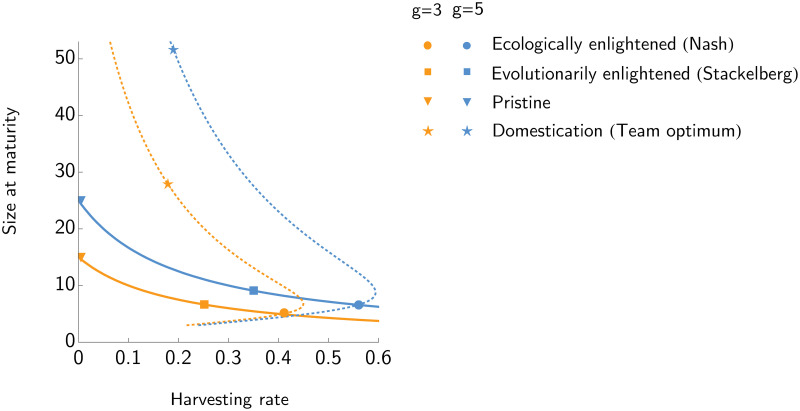
The best responses of the fish and of the manager.The ESS size of the fish (solid line) and the best response of the manager (dotted line) for two different values of the juvenile growth rate: g = 3 (orange) and g = 5 (blue). For this example, R = 4, z = 3, d = 0.2, c = 5 and s = 1. The ESS size of the fish increases with juvenile growth rate and decreases with harvesting rate, the optimal harvesting rate for the manager increases with juvenile growth rate. The Nash equilibrium lies at the intersection of the ESS curve of the fish and the best response curve of the manager, the Stackelberg equilibrium and the pristine lie on the ESS curve of the fish but not on the best response curve of the manager, while the team optimum lies on the best response curve of the manager, but not on the ESS curve of the fish.